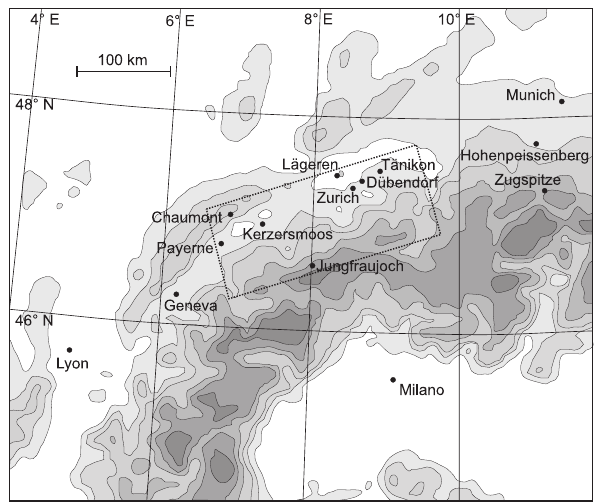
Fig. 1. Map of the study area with the locations of all measure- ment sites. The rectangle indicates the domain considered for pho- tochemical modeling. Shaded areas give the topography from the Swiss Model (SM). Contour lines are drawn at 500, 750, 1000, 1500, 2000 and 3000 m